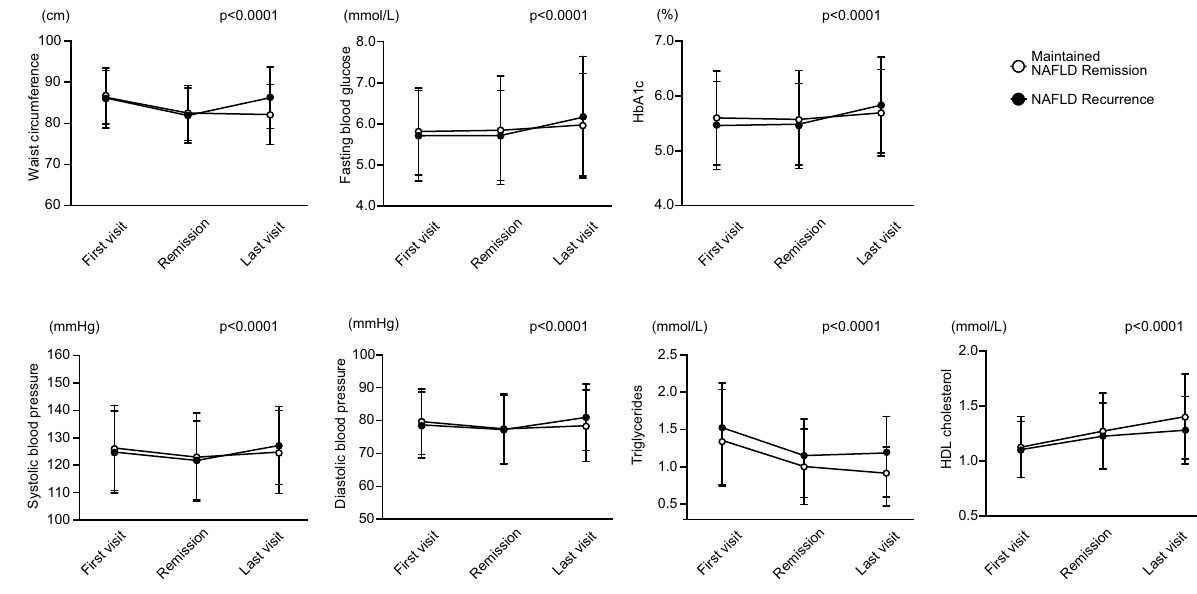
Figure 4. Changes in metabolic syndrome parameters. Data are shown as mean ± SD or median (25th, 75th). The p values were calculated using two-way repeated-measures analysis of variance. HbA1c, hemoglobin A1c; HDL, high-density lipoprotein; NAFLD, nonalcoholic fatty liver disease. Non-exercise group (participants who do not exercise regularly at the last visit) ALL n = 877 n = 1247